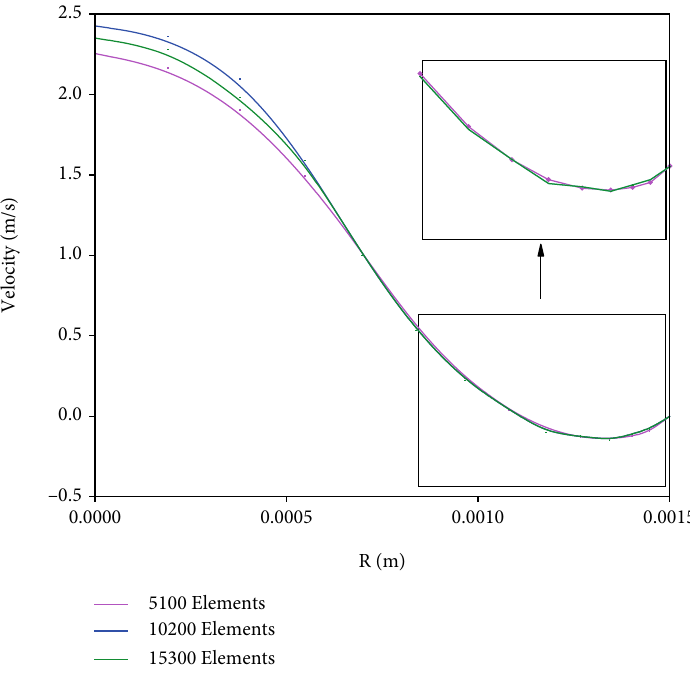
Figure 5: Grid independency of the results.